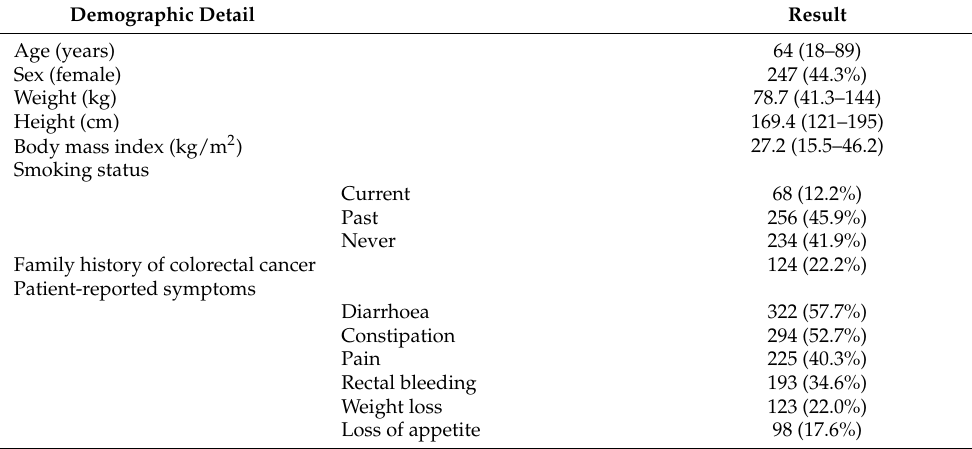
Figure 2. PRISMA participant flow chart for study participants. Table 1. Demographic data of participants enrolled in the study. Data are means (range) or number of patients.